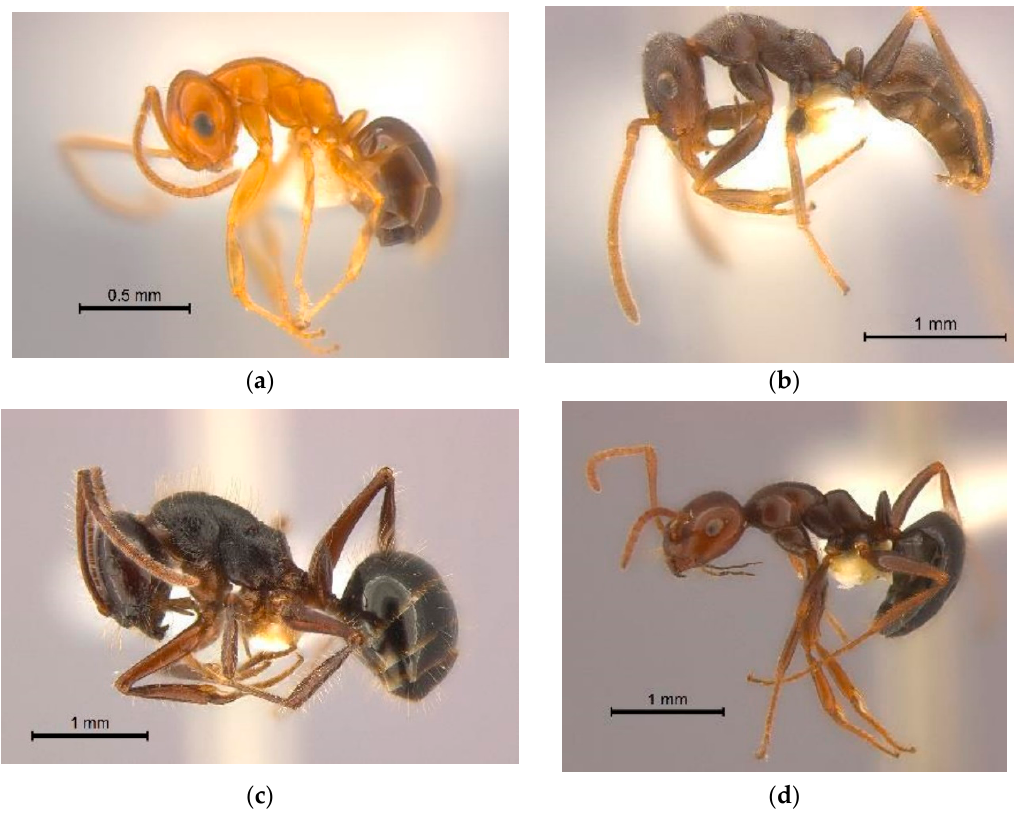
Figure 5. Representatives of the M. ludius radiation. ( a ) M. ludius ; ( b ) M. mjobergi ; ( c ) M. hirsutus ; and ( d ) member of Melophorus Group D.